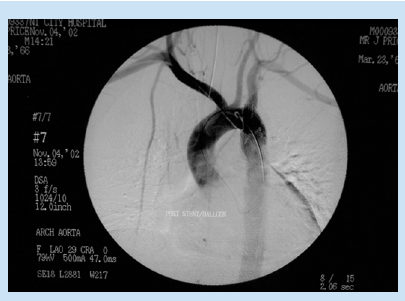
Fig. 3b. Successful occlusion of the pseudo- aneurysm with an endoluminal